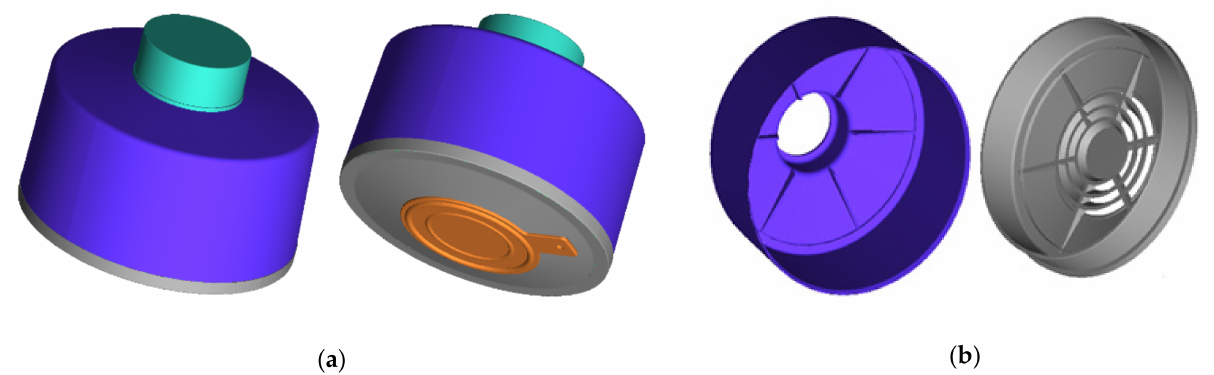
Figure 1. Combined filter. ( a ) Overall view; ( b ) Canister parts.